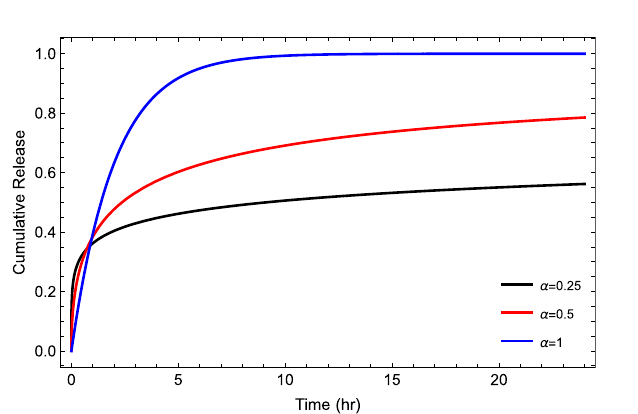
Figure 7. Plot corresponding to the data sets of in vitro Gen-DNA nanospheres with the fitted curve of Eq. (13). The best fitting parameter values are α = 0.33 , R = 0.75 , (cid:31) = 0.2 and σ 0 = 0.414 .